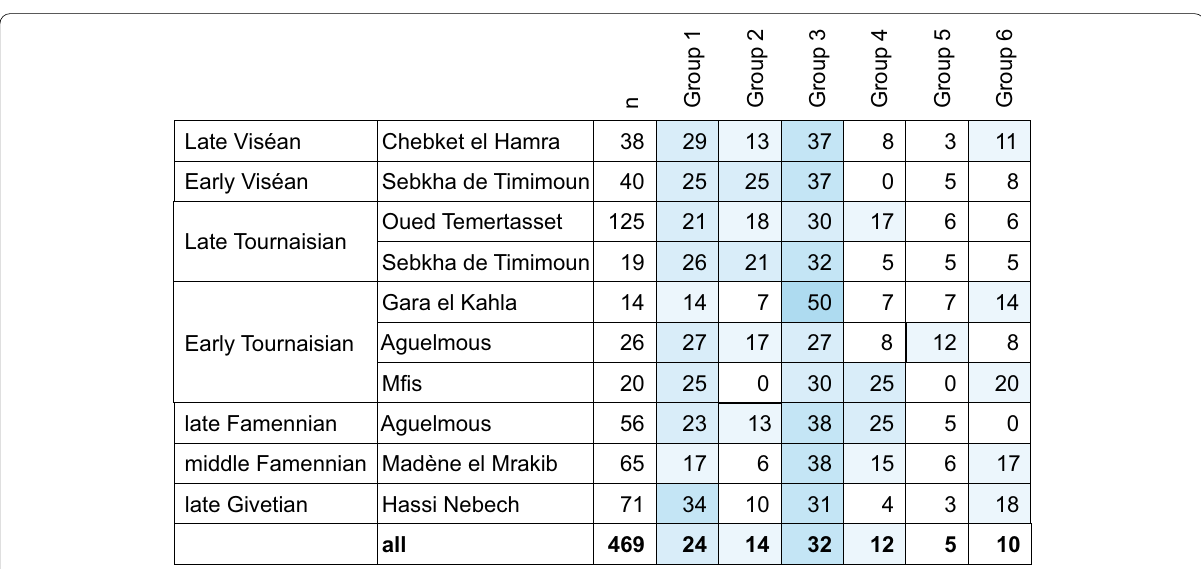
Fig. 5 Numbers of percentages of the six distinguished groups with different modes of septal distance in the stratigraphically successive assemblages